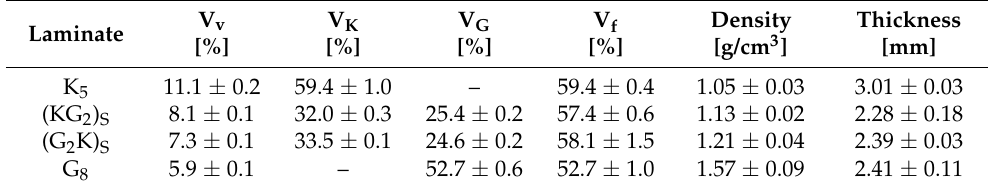
Table 1. General characteristics of the